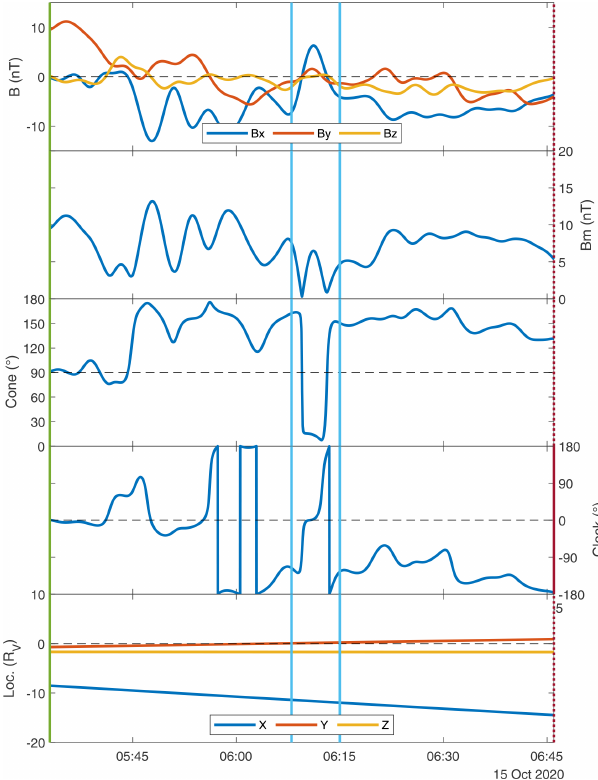
Figure 6. Zoom-in on the neutral sheet crossings interval (blue). Strong oscillations of the field also occur before the selected inter- val, without crossing B x =